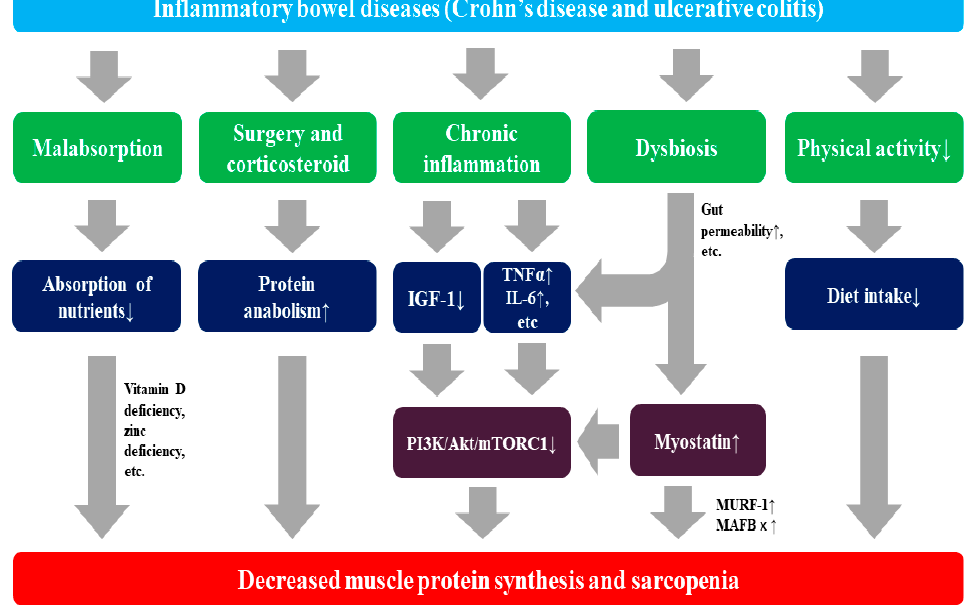
Figure 1. Mechanism for sarcopenia in patients with inflammatory bowel disease (IBD). IBD can cause sarcopenia through a variety of pathologies and immune responses. TNF α : tumor necrosis factor α , IGF-1: insulin-like growth factor 1, mTORC1: mechanistic target of the rapamycin complex 1, IL-6: interleukin-6, PI3K: phosphoinositide 3-kinase, MURF-1: muscle RING finger 1, MAFB x: muscle atrophy F-box.